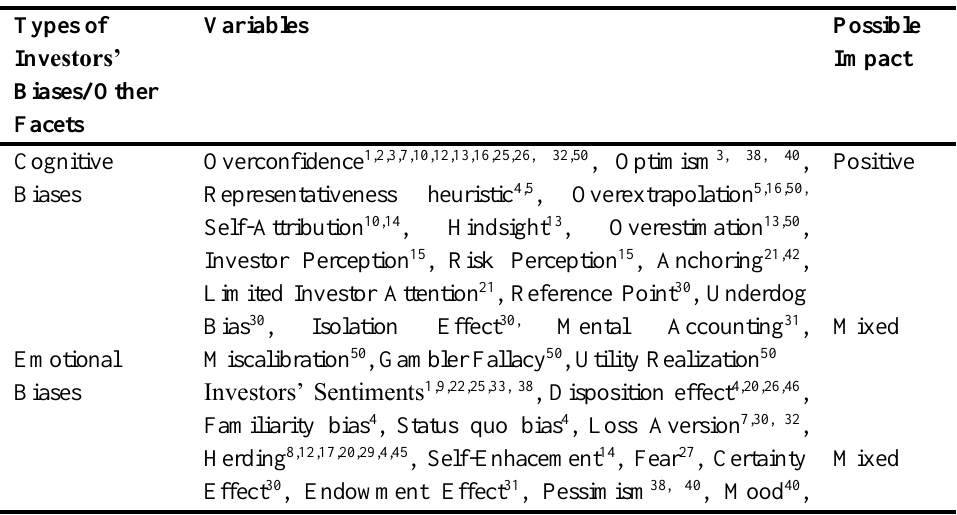
Table.4. Investors’ Biases in the Context of Stock Return Volatility & Their